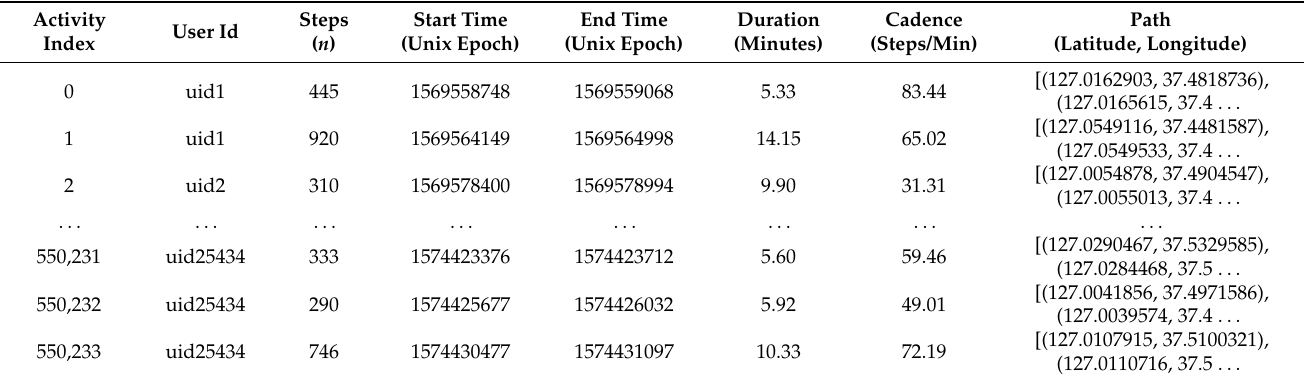
Table A1. Example of walking activity dataset, from the mHealth monitoring system of Seoul.